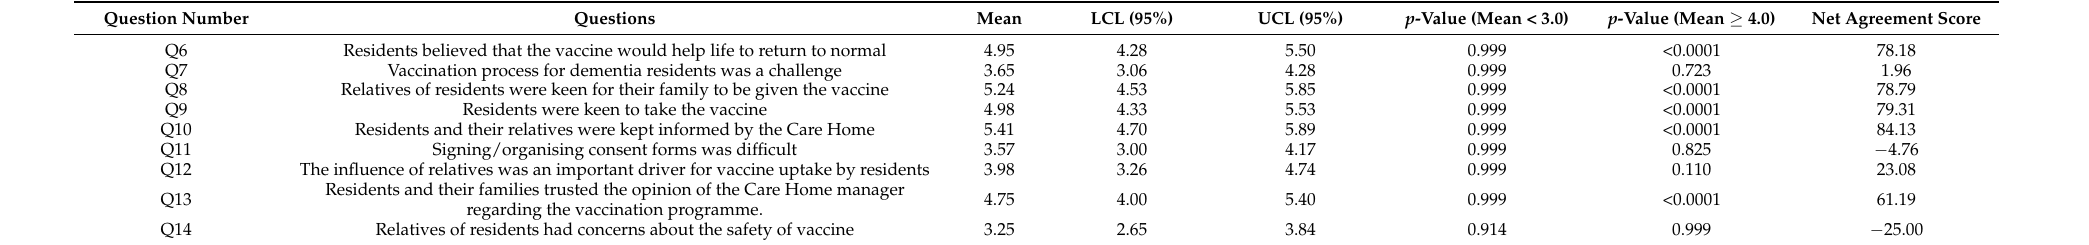
Table 3. Analyses of uptake level of COVID-19 vaccination programme in care homes by residents.